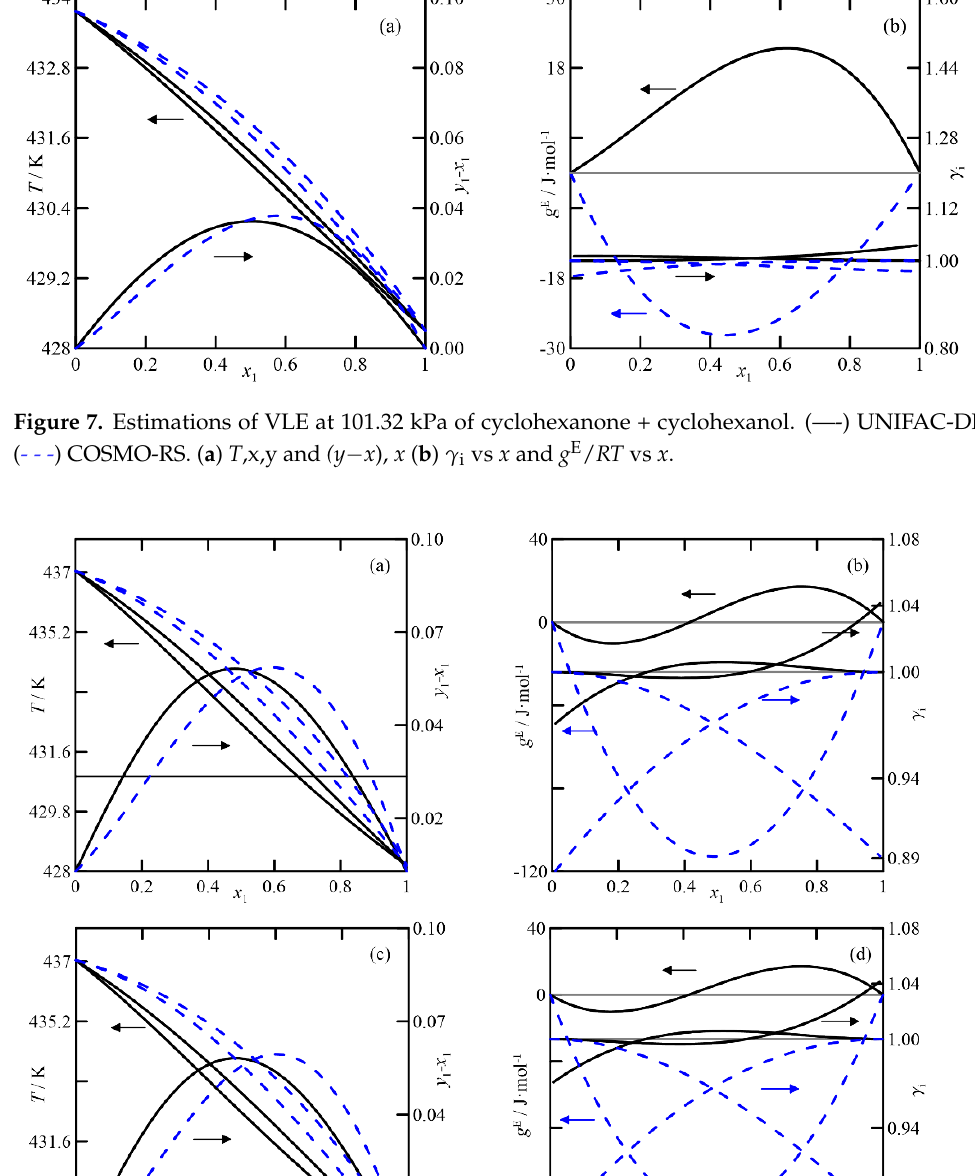
Figure 7. Estimations of VLE at 101.32 kPa of cyclohexanone + cyclohexanol. (----) UNIFAC-DM; (- - -) COSMO-RS. ( a ) T ,x,y and (y − x ), x ( b ) γ i vs x and g E / RT vs x. (iii/iv) Cyclohexanone + (2 or 3)-cyclohexen-1-ol: The VLEs of cyclohexanone with two